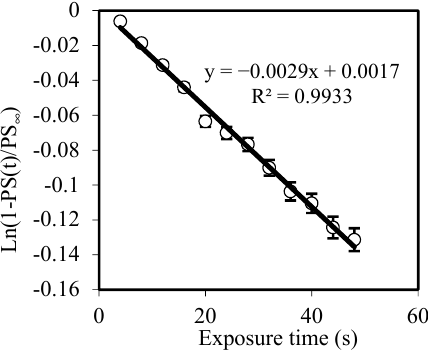
Figure 8. Fitting derived from Equation (3) to extract the value of polymerization rate ( F R ).